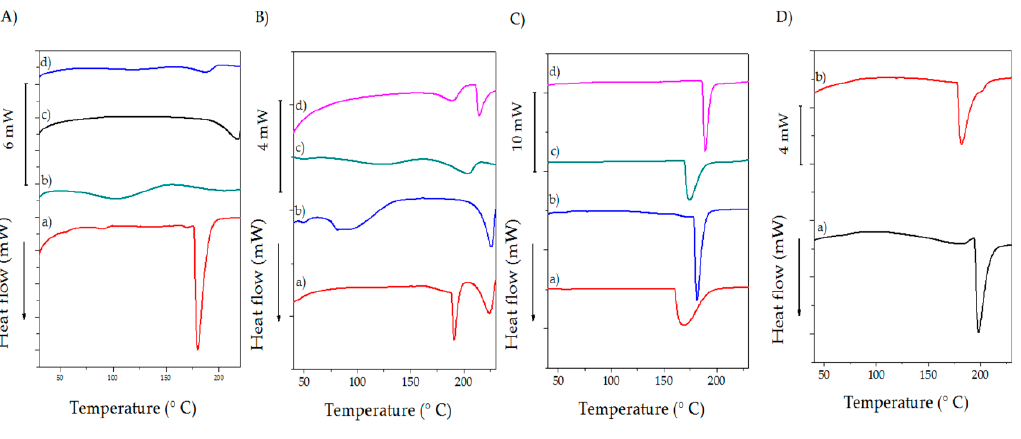
Figure 3. Thermogram for BAPS. ( A ). Polymers with and without ADD: (a) CHI; (b) CHI/ADD; (c) PVA; (d) PVA/ADD; ( B ) PVA blends: (a) PVA/AMP 0.3%; (b) PVA/AMP 1%; (c) PVA/ADD/AMP 0.3%; (d) PVA/ADD/AMP 1.0%; ( C ) CHI blends: (a) CHI/AMP 0.3%; (b) CHI/AMP 1.0%; (c) CHI/ADD/AMP 0.3%; (d) CHI/ADD/AMP 1.0%; ( D ) PVA/CHI blends: (a) PVA/CHI/ADD/AMP 0.3%; (b) PVA/CHI/ADD/AMP 1.0%.